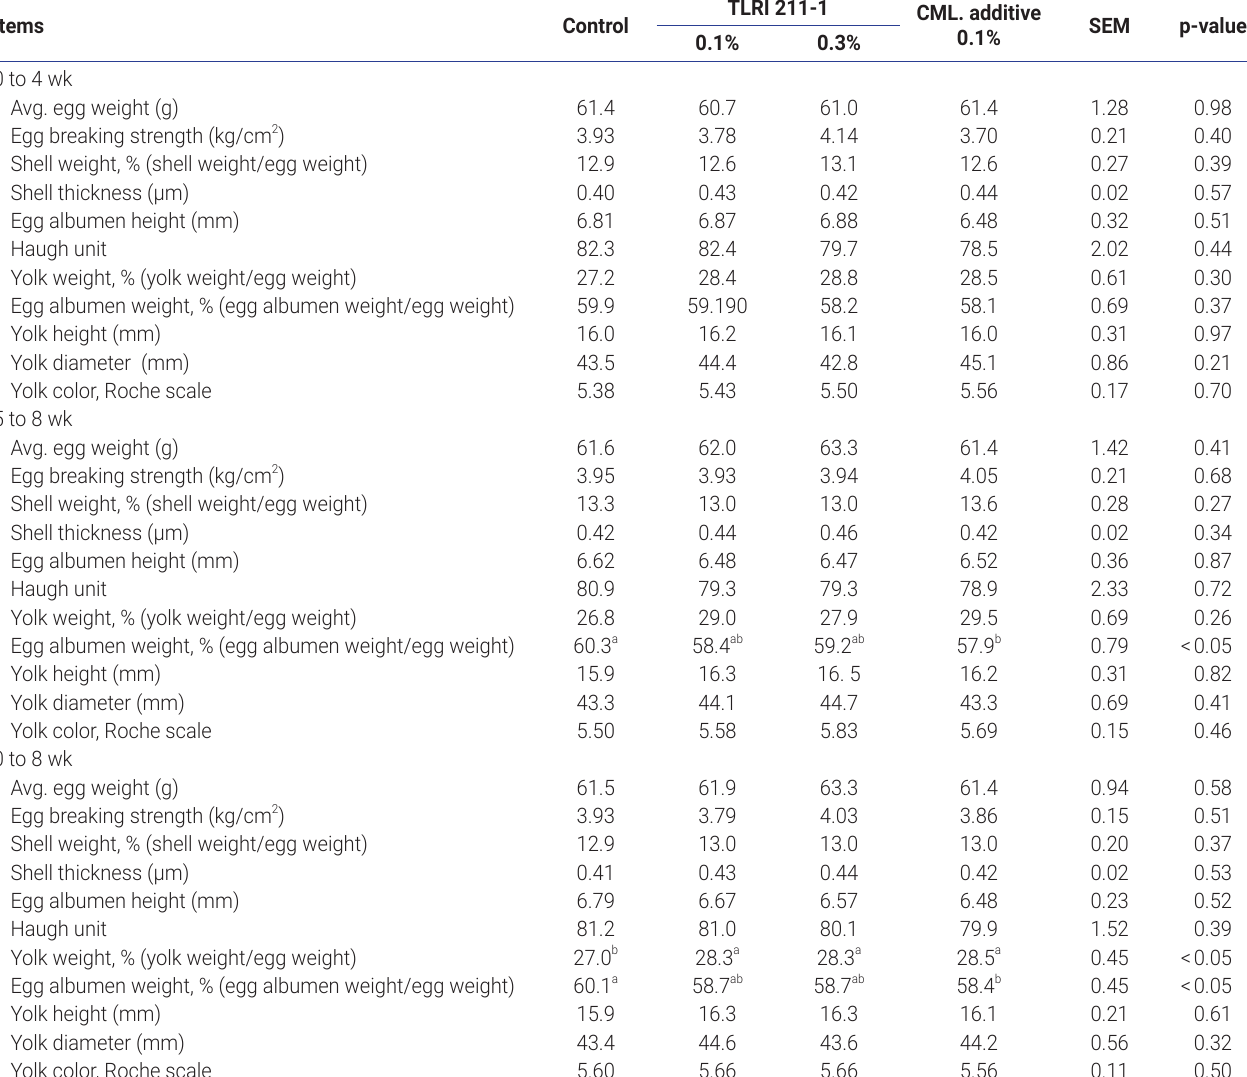
Table 4. Effects of dietary supplementation of Bacillus subtillis and B. amyloliquefaciens on egg quality of Leghorn laying hens Items